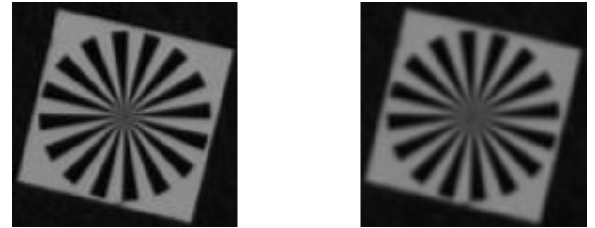
Figure 6. Visual impression of original image (left) and the same image blurred by Gaussian filter (right)